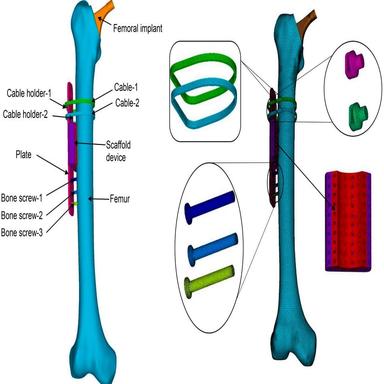
FE model of femur bone with the fracture fixation assembly, femoral implant, and AMTD.